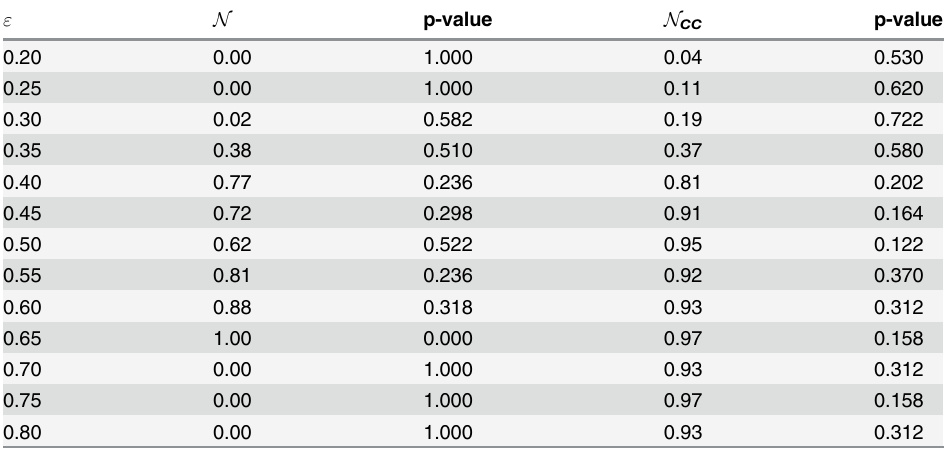
Table 1. Test for differential modular structure in the case and control networks for MI LURIC data. For comparison, the same statistics and p-values are given for complete case (CC) data with subgroup of lipids from which 90% of the values were detected.